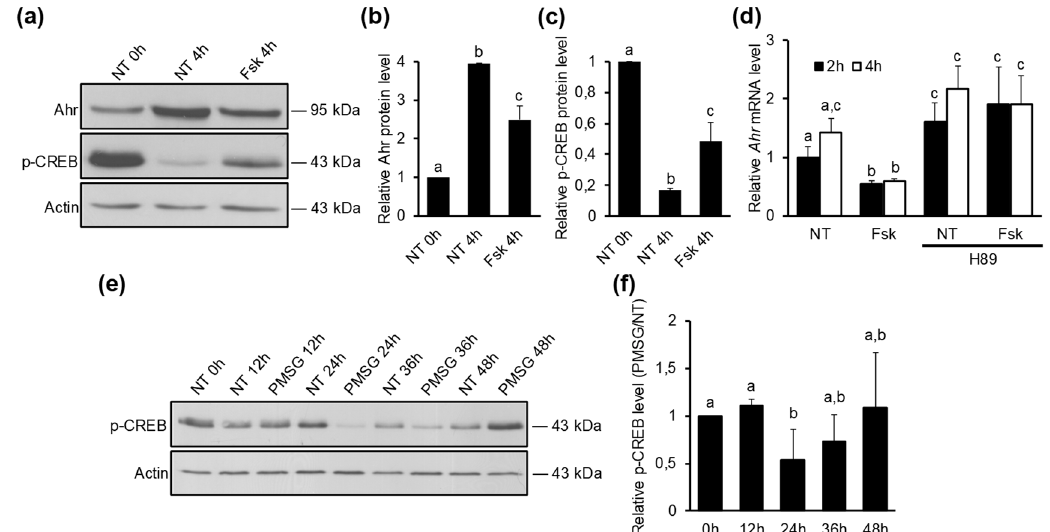
Figure 4. The e ff ect of PKA signaling on Ahr expression. ( a ) Mice were treated with 5 IU of PMSG for 24 h in vivo, GCs were isolated and cultured in vitro. Following attachment (2–3 h later), GCs were treated with vehicle (NT) or Fsk (10 µ M). Representative Western blot shows Ahr, p-CREB and actin levels in GCs before (0 h) and 4 h after vehicle (NT) or forskolin (Fsk, 10 µ M) treatment. ( b ) Densitometry analysis of three independent experiments (mean ± SD) representing Ahr protein levels normalized to actin. ( c ) Densitometry analysis of three independent experiments (mean ± SD) representing p-CREB protein levels normalized to actin. ( d ) Mice were treated with 5 IU of PMSG for 24 h in vivo, GCs were isolated and cultured in vitro. Following attachment (2–3 h later), GCs were treated with vehicle (NT) or Fsk (10 µ M) alone or in combination with PKA inhibitor H89 (10 µ M). Ahr mRNA levels were measured 2 h and 4 h later by qPCR. ( e ) Representative Western blot shows p-CREB and actin protein levels measured in GCs isolated before (0 h) or up to 48 h after PMSG (5 IU) or vehicle treatment in vivo. ( f ) Densitometry analysis of p-CREB protein levels. The data are presented as ratio of PMSG vs, NT for di ff erent timepoints from three independent experiments (mean ± SD). Bars with no common superscripts are significantly di ff erent ( p < 0.05).